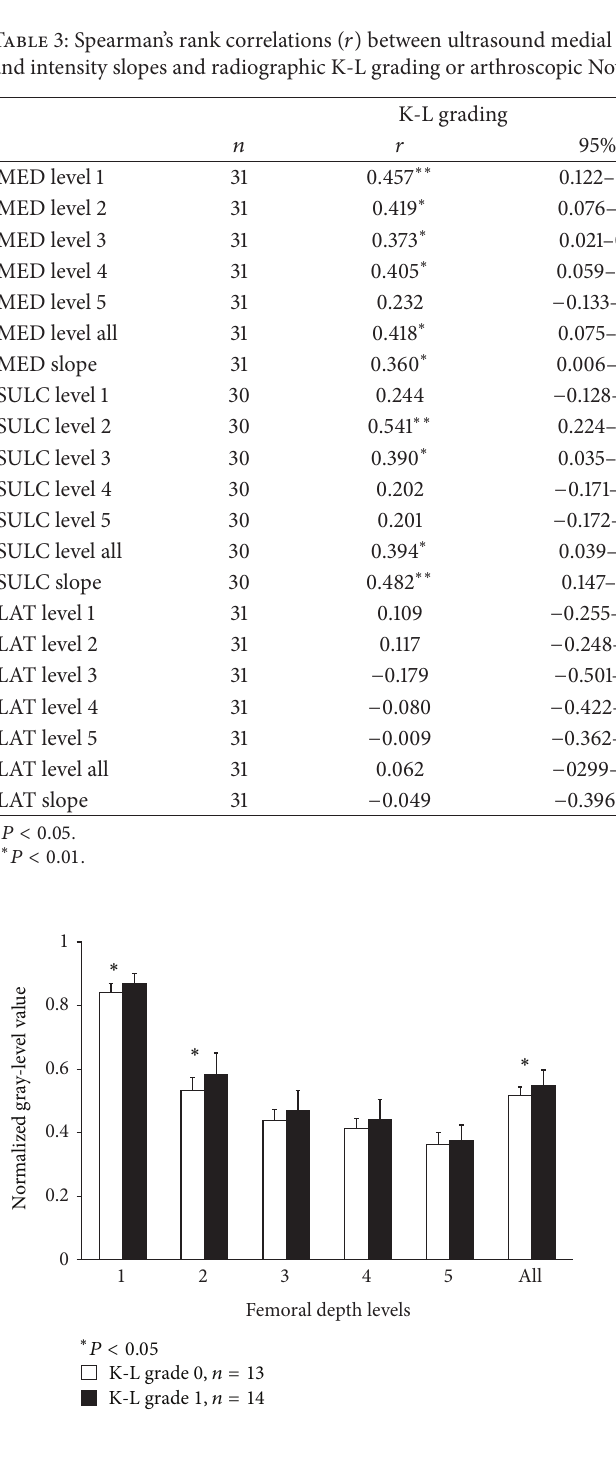
Figure 3: Normalized mean gray-level intensity values in different femoral bone depth levels using grouping radiographic Kellgren- Lawrence (K-L) grade 0 and